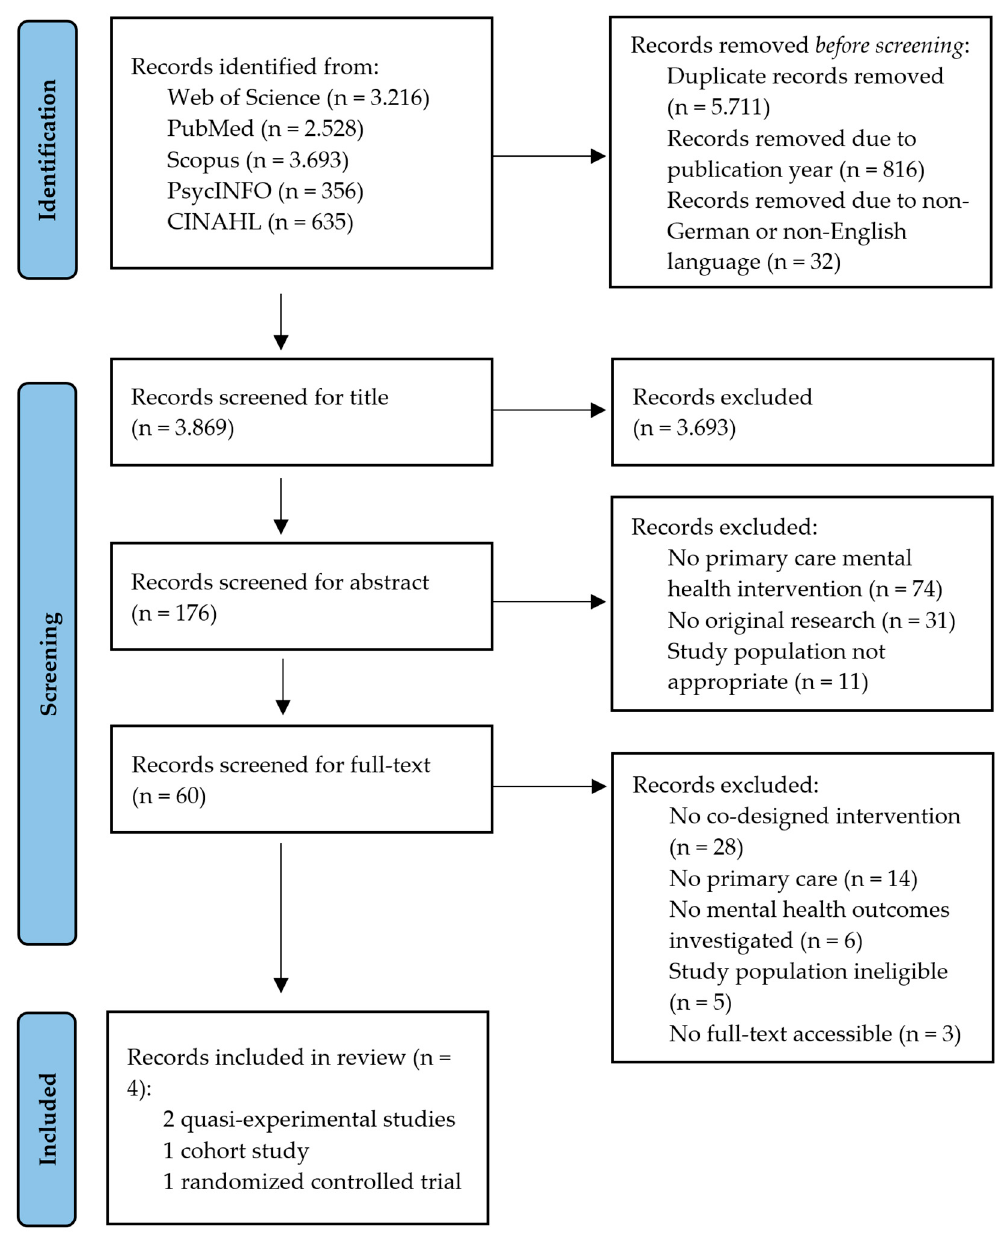
Figure 1. Flow chart of literature search.